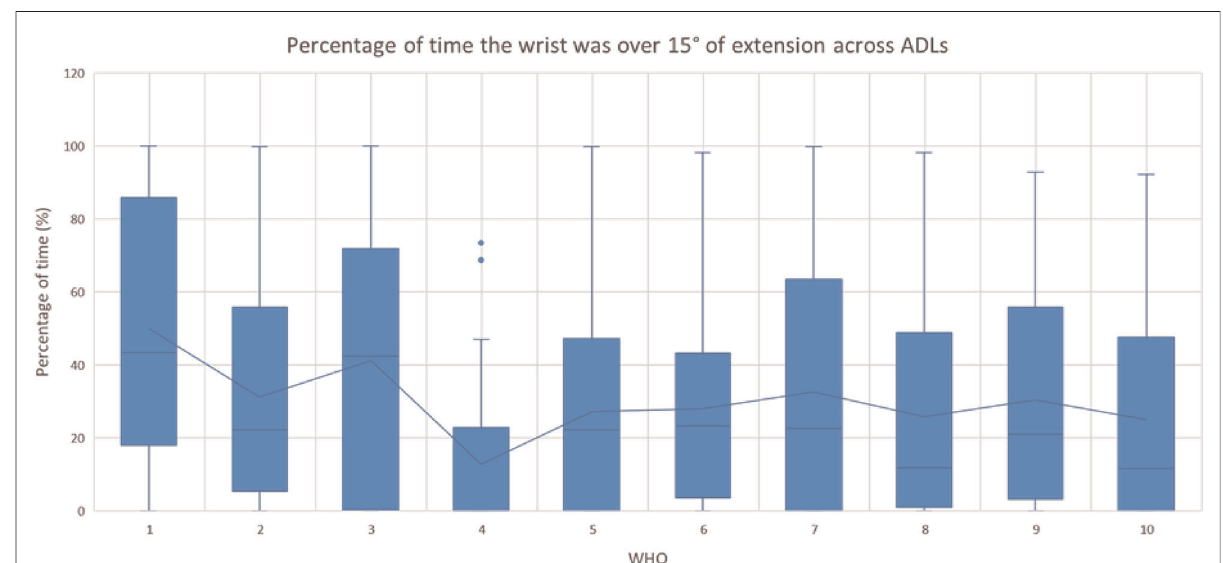
FIGURE 3 Percentage of time when the wrist adopted a fl exed position throughout the activity. In the fi gures, the outliers are shown with the points, and each mean is shown by the lines. Statistical signi fi cance is shown by * and ** when the mean was statistically greater than 0, for p <0.05 and p <0.001, respectively. The mean for each group is shown by the lines, and the outliers are shown with the